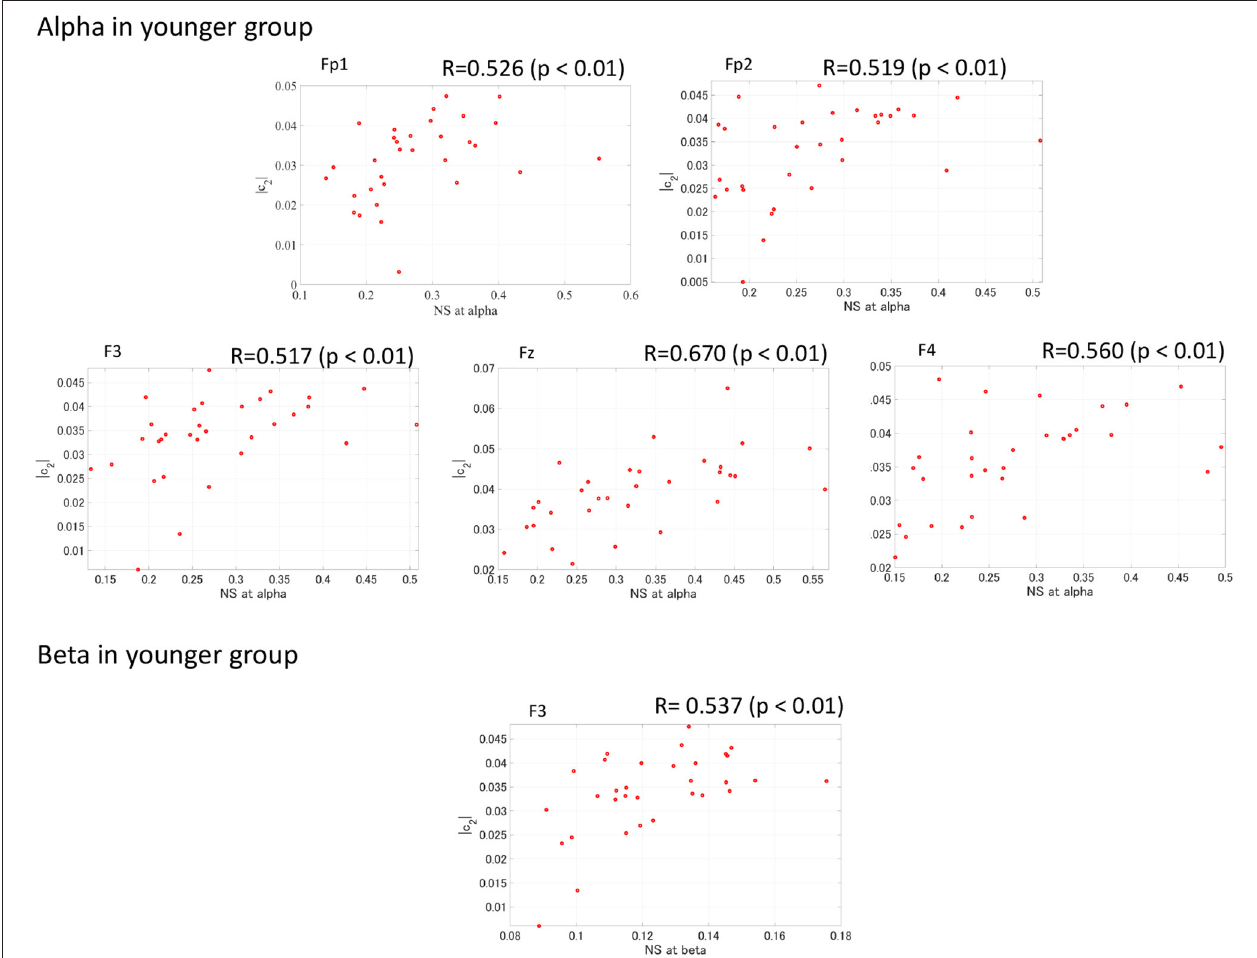
FIGURE 7 | Scatter plot between NS of PLI at alpha/beta bands and | c 2 | in younger group where Spearman’s rank correlation R coefficient satisfies with FDR correction criteria of q < 0.050 in Figure 6 . The significant large positive correlations were observed.